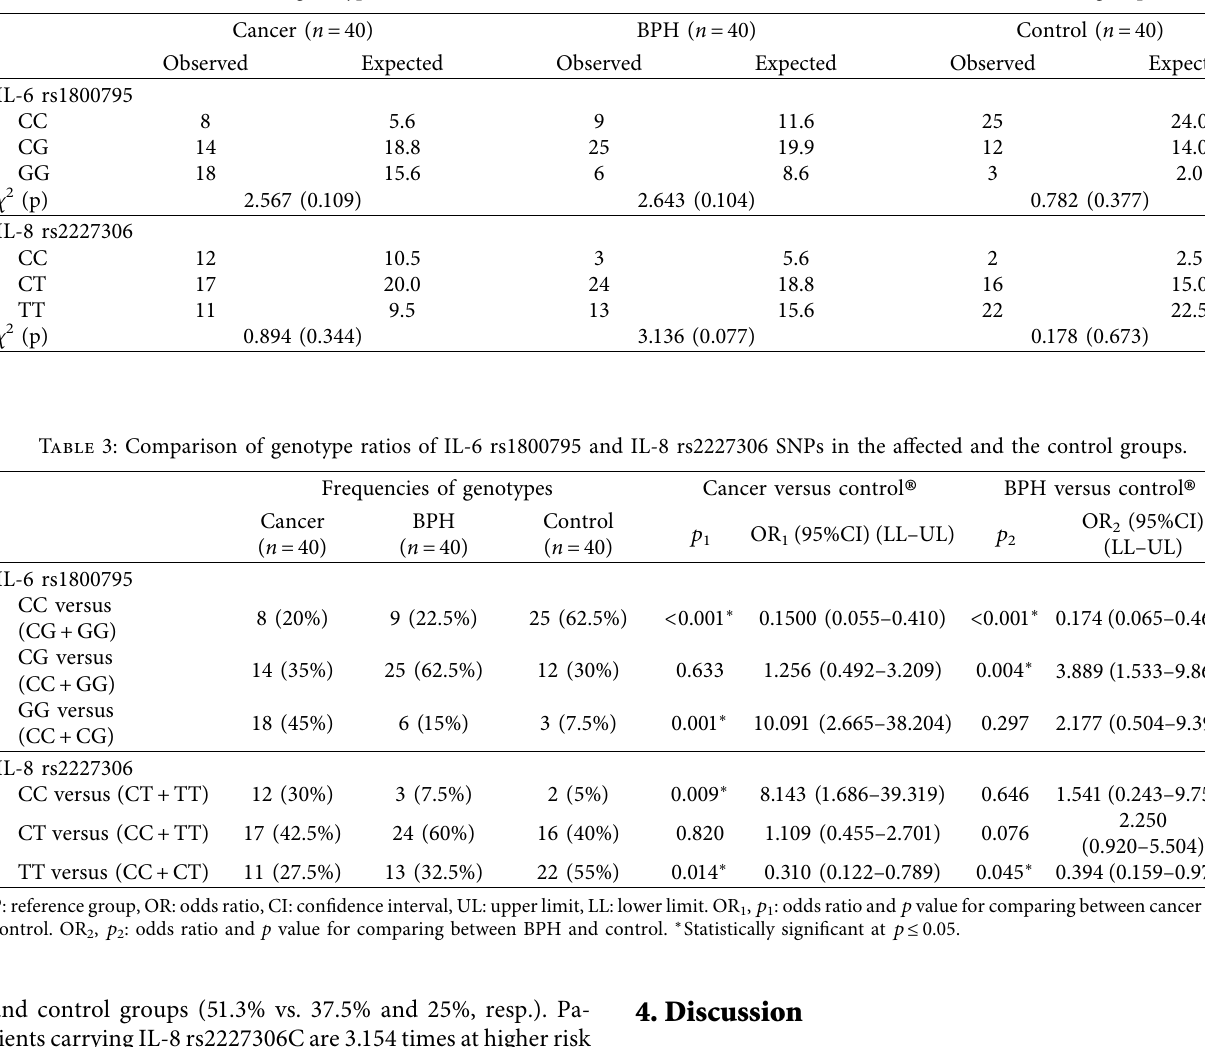
Table 2: Distribution of genotypes of IL-6 rs1800795 and IL-8 rs2227306 SNPs in the affected and the control groups.